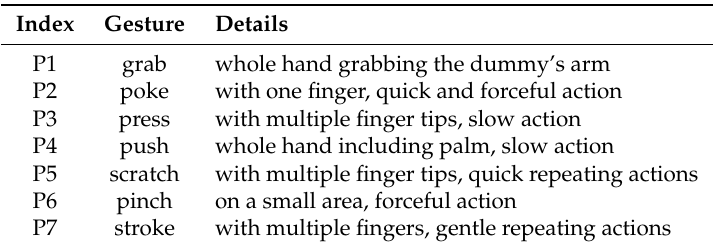
Table 1. Prediction class of gestures